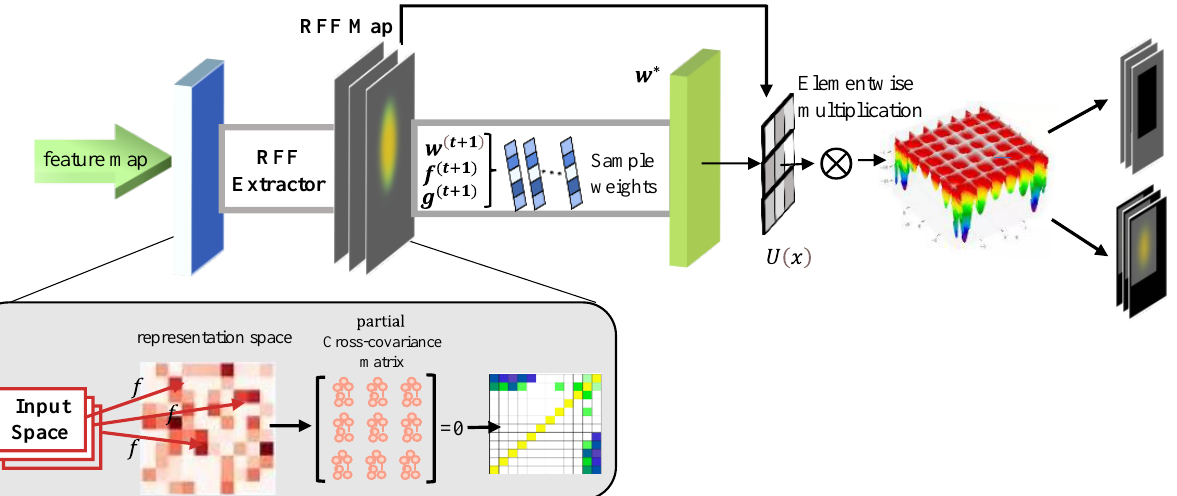
Figure 4. The architecture of feature decorrelation module. The overall process takes place during the training phase and consists of removing all linear and non-linear relationships between features (Section. 3) as well as global weight optimization (Section. 2).